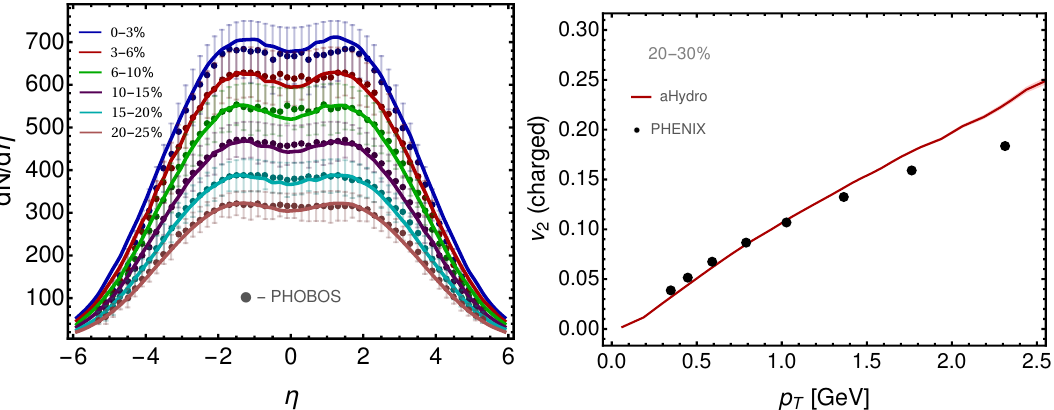
Figure 2. In panel ( a ), a comparison of the charged particle multiplicity in different centrality classes (0–25%) is shown between aHydroQP and experimental data which is taken from the PHOBOS collaboration [20]. In panel ( b ), the elliptic flow for charged particles in 20–30% centrality class is shown where 3+1d aHydroQP predictions is compared to data taken from the PHENIX collaboration [21]. Figure is taken from